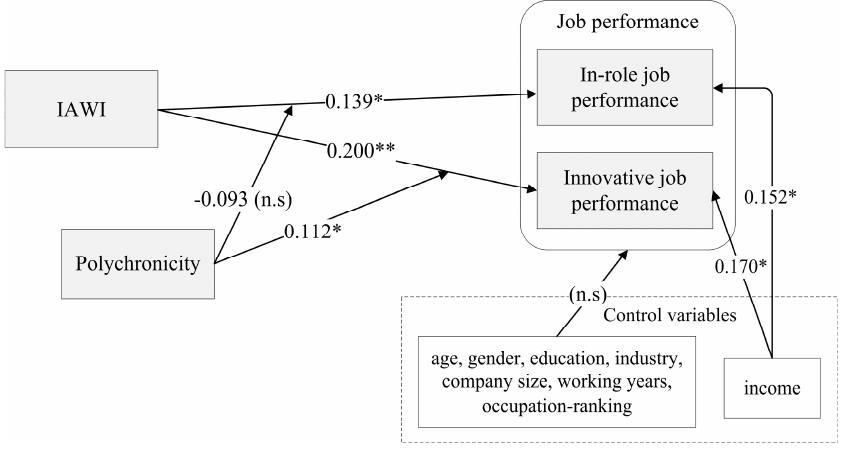
Figure 2. Results of path-model analysis. * p < 0.05, ** p < 0.01. Table 5. Summary of path coefficients and significant